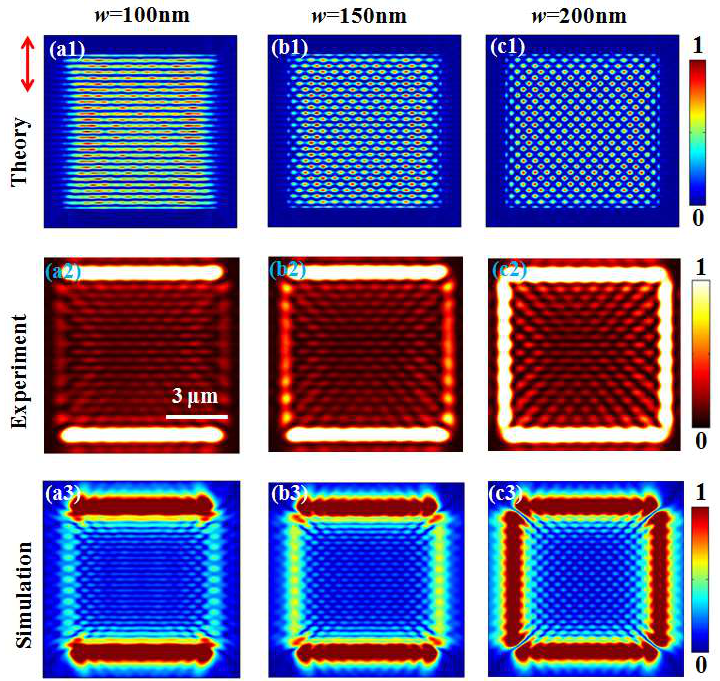
Figure 3. For vertically polarized incident light (indicated by the red arrow), ( a1 )–( c1 ) describe the normalized theoretical intensity distributions of 2 ( , ) E x y | | generated by the square slits with different widths. The optical patterns evolve from horizontal stripes to diamond-like dot array with the increase in slit width. ( a2 )–( c2 ) and ( a3 )–( c3 ) are the corresponding experimental and finite-difference time-domain (FDTD) results. The slit widths of square-slit samples are 100 nm, 150 nm and 200 nm, respectively.